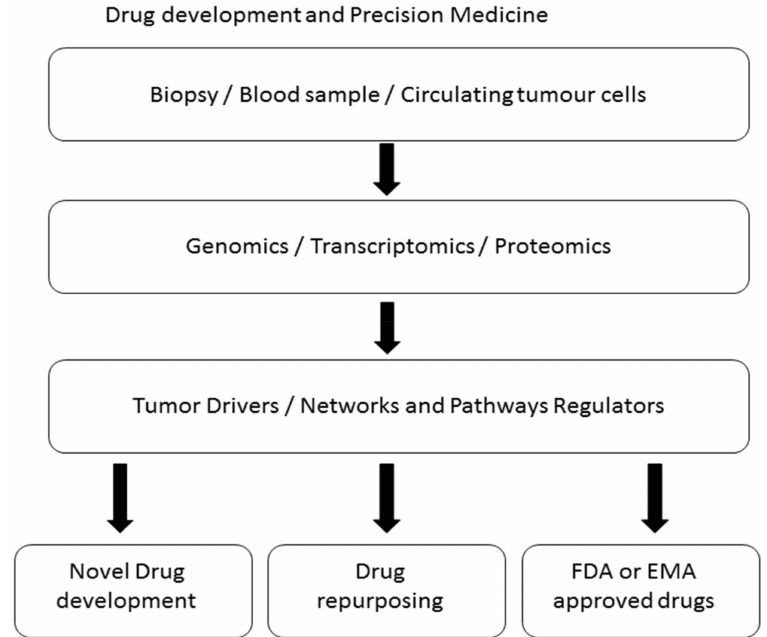
Figure 4. Precision therapies in oncology can be designed to only affect cancer cells. Biomarkers can be identified through next generation sequencing, gene expression profiling and proteomics. Drivers